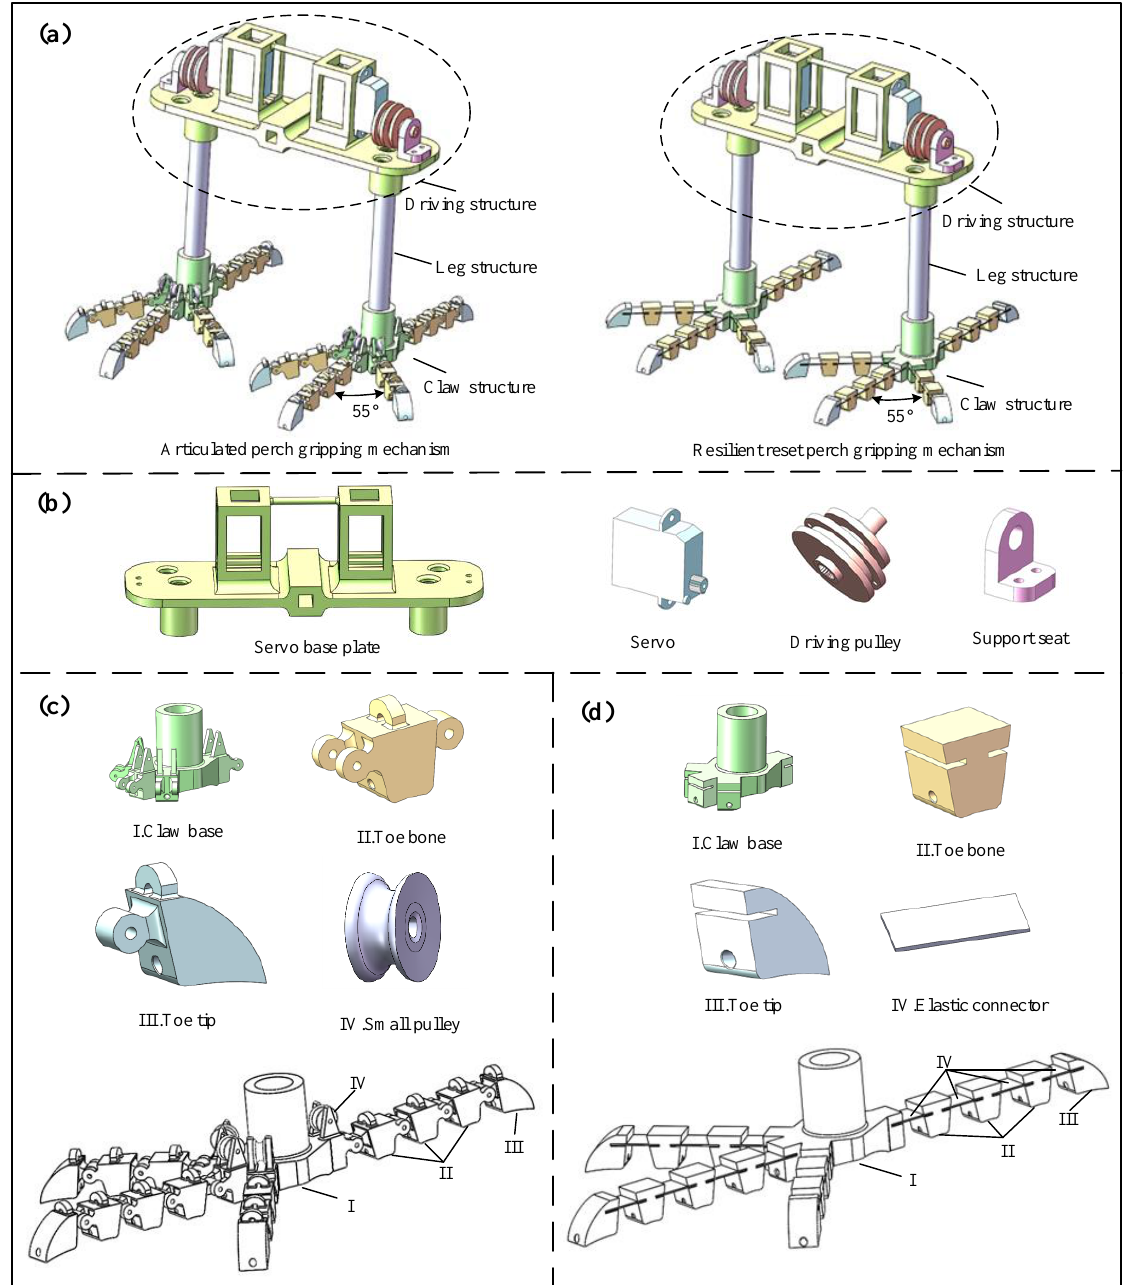
Figure 2. Design of the perch gripping mechanism. ( a ) Overall structural design of the two perching grasping mechanisms. ( b ) Drive structural parts. ( c ) Articulated jaw structural parts. ( d ) Resilient reset jaw structural parts.